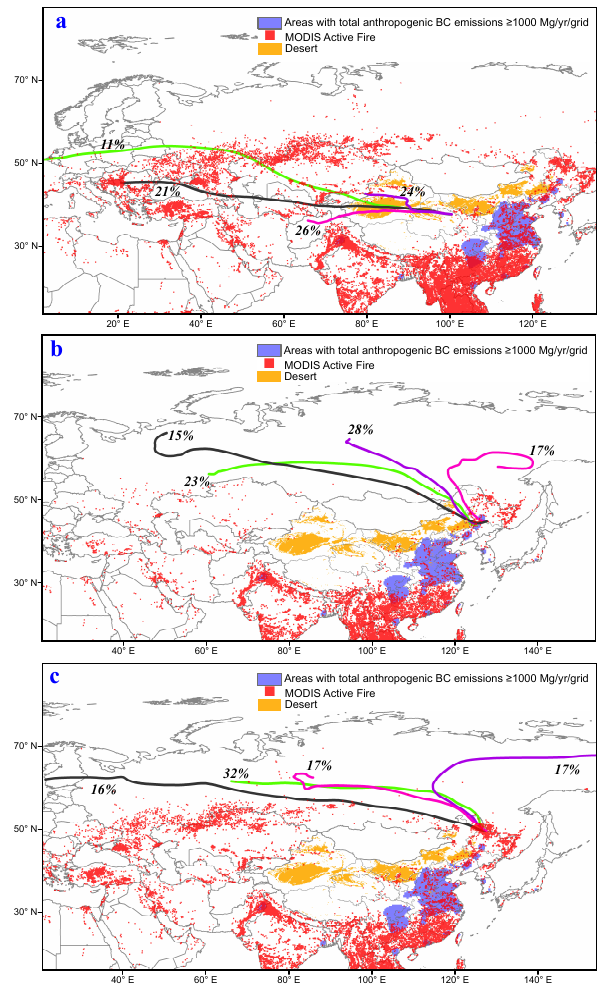
Fig. 5. Back trajectory analysis for three of the regions discussed in the text. A seven cluster analysis back trajectory was done on each of the regions with mean trajectories shown for each cluster that encompassed 10% or more of the back trajectories. (a) Region 7 (Qinghai-Tibet Plateau), 536 total trajectories; (b) Region 5 (in- dustrial northeast), 336 total trajectories; and (c) Region 4 (clean northeast), 400 total trajectories. Note that, as in Fig. 1, the fires shown are those detected over the entire snow accumulation